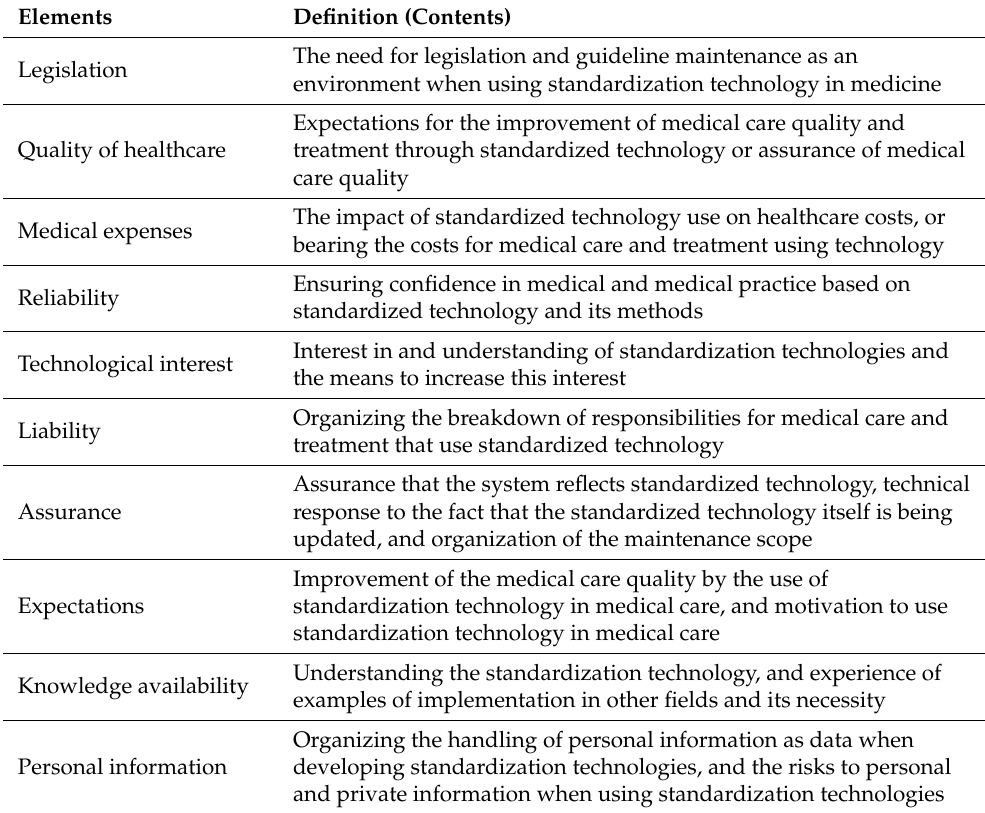
Table 2. Definition of elements.